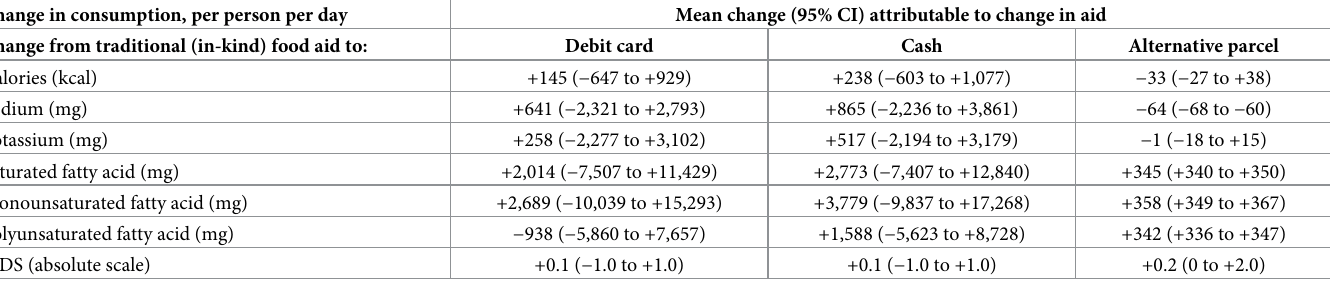
Table 3. Estimated changes in nutrition from a change in food aid. Model-derived estimates of changes in dietary intake measures attributable to a change from food parcel to electronic debit card delivery of food aid; a change from food parcel to cash aid; or a change from food parcel to alternative food parcel with less grain and increased fruit and vegetable content.